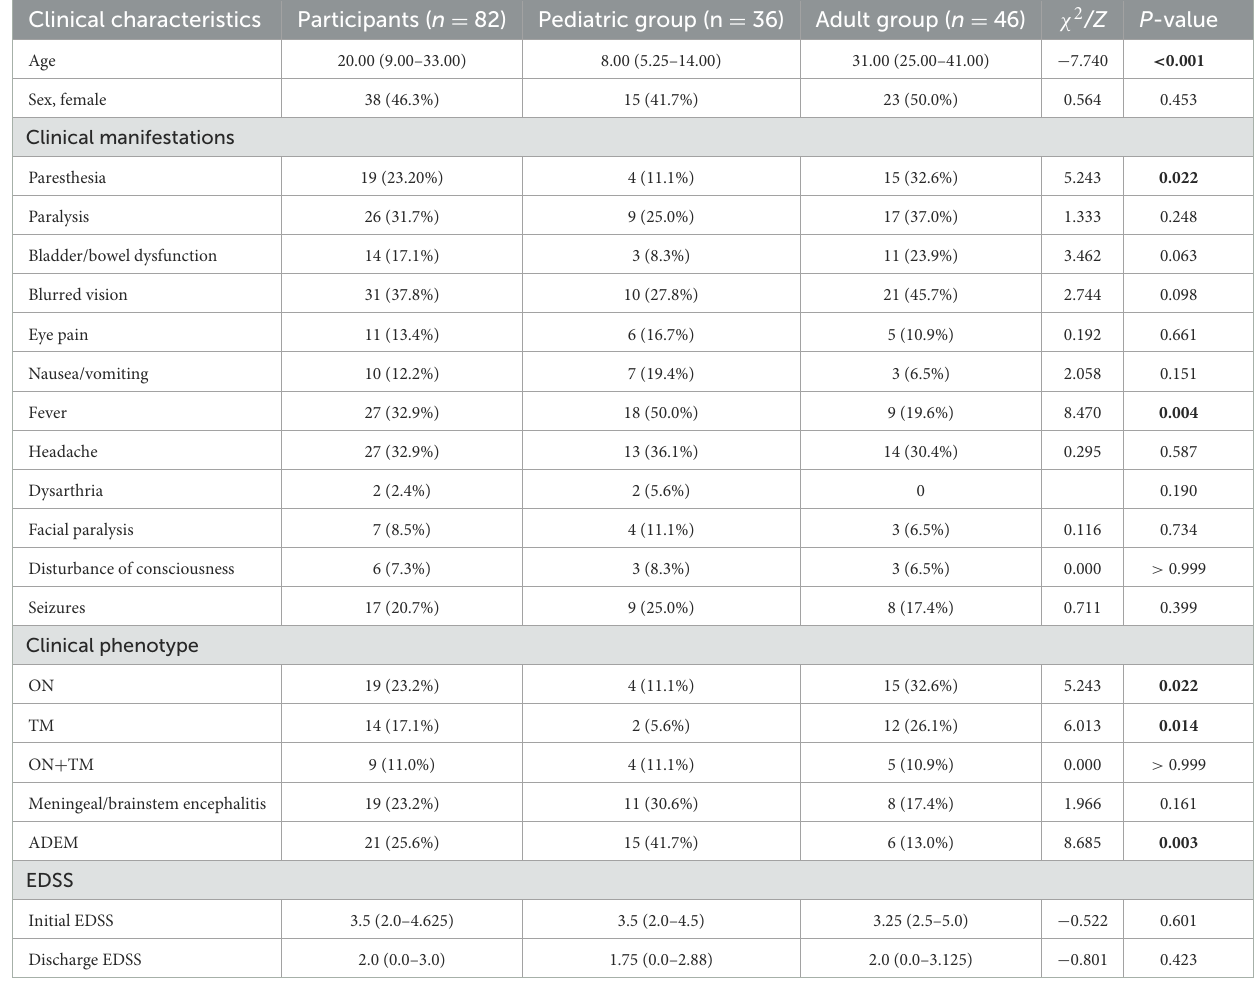
TABLE 1 Clinical characteristics of patients in different age groups. Clinical